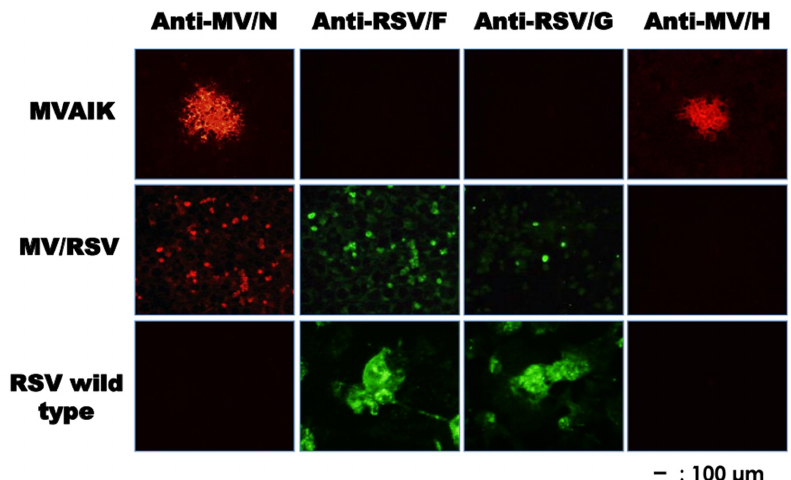
Figure 3. Immunostaining of Vero cells infected with MVAIK, MV/RSV, and RSV. Monoclonal antibodies against RSV F or G protein and secondary antibody against mouse IgG conjugated with FITC were used for the detection of RSV F or G protein. Monoclonal antibody against MV HA pro-